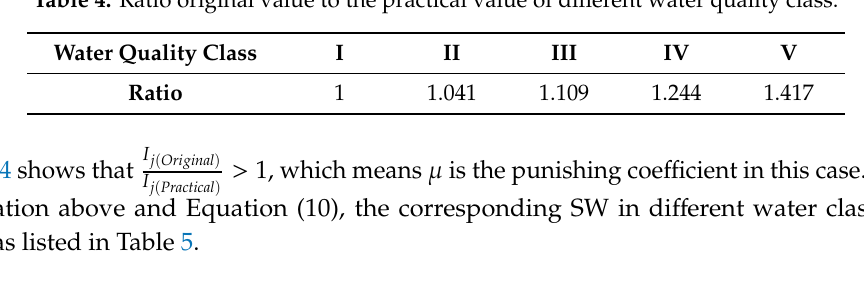
Table 4. Ratio original value to the practical value of di ff erent water quality